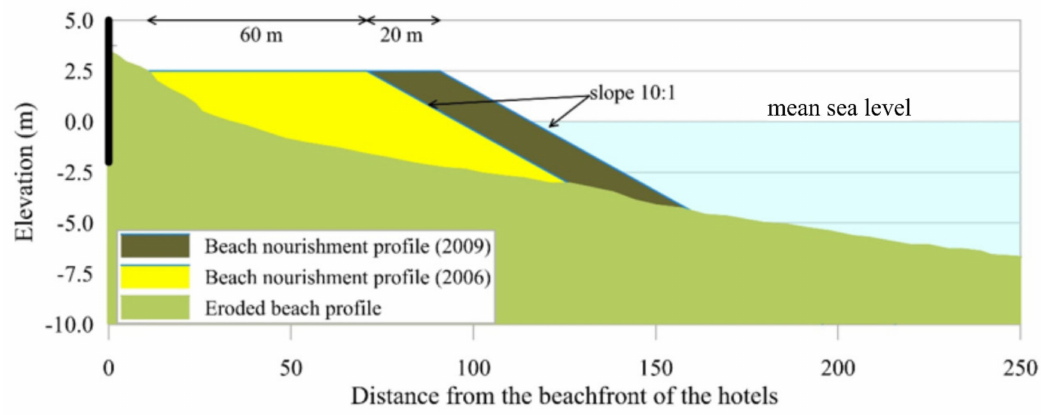
Figure 9. Projected profiles for the 2006 and 2009 beach